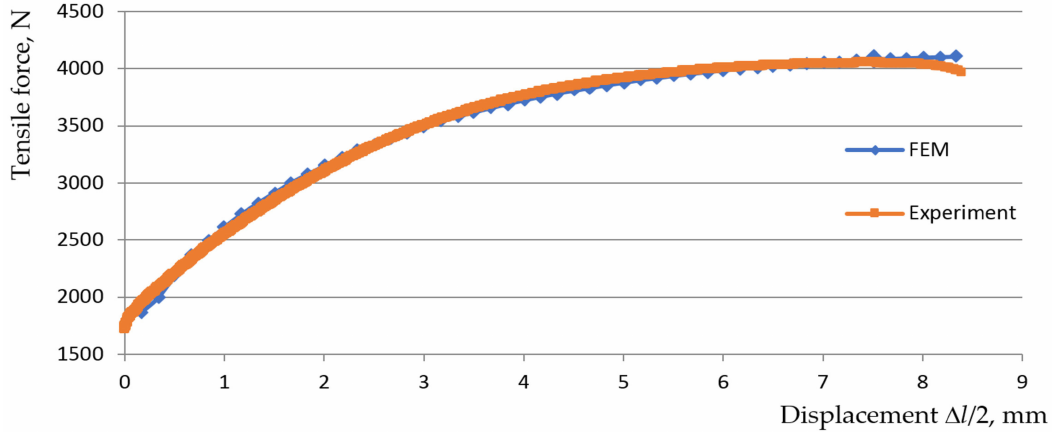
Figure 15. Tensile force as a function of